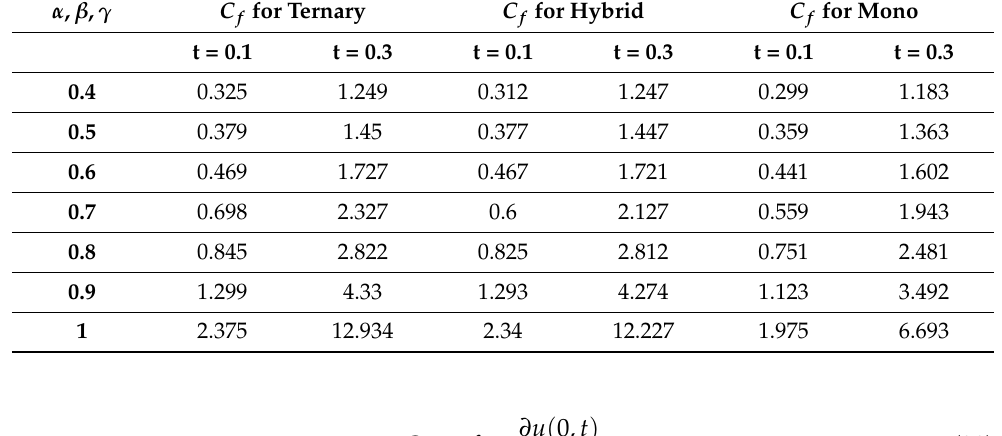
Table 4. Effect of time and fractional parameter on skin friction (Ternary, Hybrid and Mono nanoparticles). α , β , γ C f for Ternary C f for